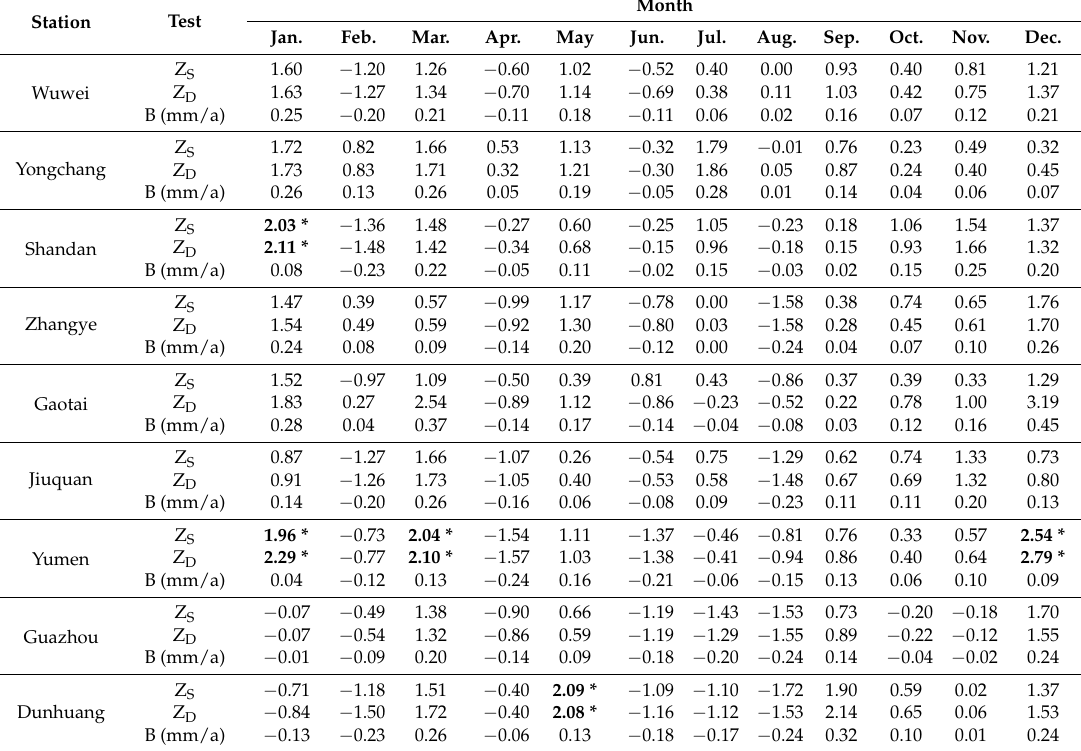
Table 7. Statistical tests for monthly precipitation data of the nine stations during